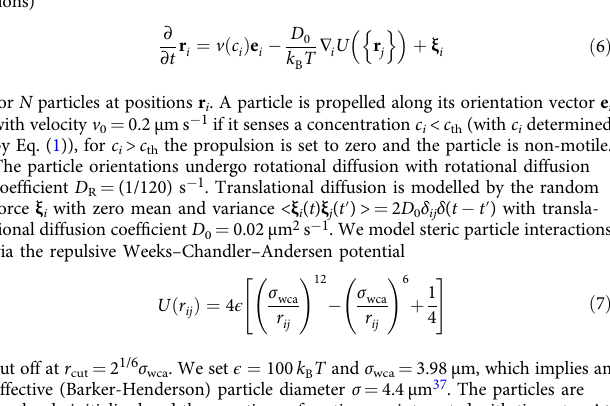
Fig. 6 Swimming velocity. Experimentally observed particle velocities (open symbols) depending on the intensity of the laser illumination. Above an intensity of I = 0.1 W mm − 2 the particle starts to self-propel by demixing the solvent around the carbon-coated hemisphere and the velocity v then depends linearly on the intensity I . In our experiments we use I = 0.2 W mm − 2 for motile particles resulting in v = 0.2 μ m s − 1 , and no illumination for non-motile particles (squares). Error bars correspond to the standard